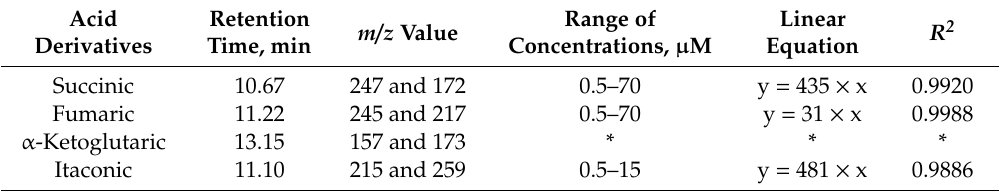
Table 3. Retention times, characteristic m / z values and equations of linear functions of trimethylsilyl derivatives of succinic, fumaric, α -ketoglutaric and itaconic